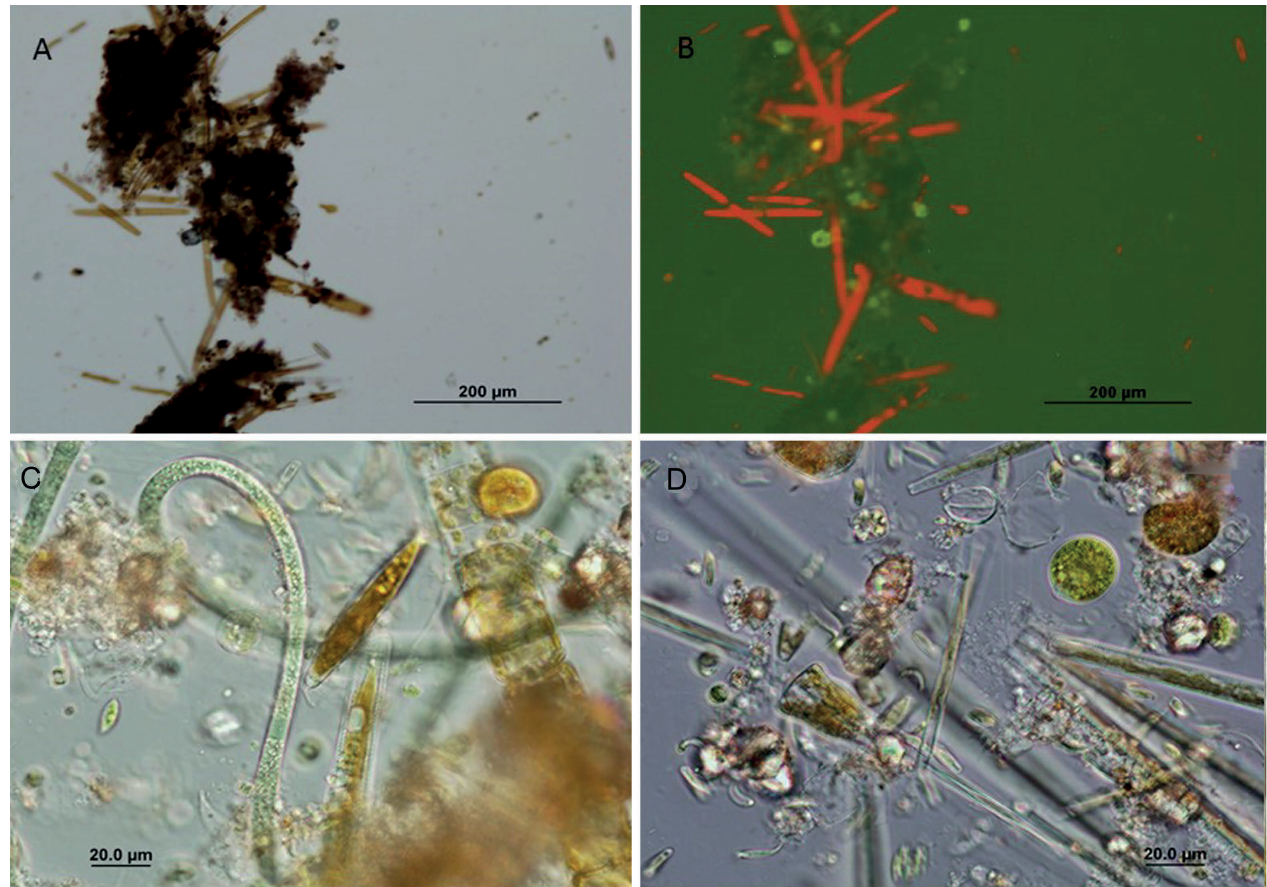
Figure 1 – Illustrations of the complex, jumbled and non-random world of freshwater biofilms as encountered with the light microscope: A, representatives of several autotrophic groups live in, on and around organic and inorganic debris, along with fungi, bacteria, heterotrophic protists and higher organisms: epilithic biofilm from Winford Brook (latitude: 51.36697, longitude: -2.621881). Organic material obscures many live cells; B, using chlorophyll autofluorescence imaging, location of pigmented cells is revealed; C, closer inspection of dispersed biofilm material reveals single-celled and filamentous diatoms intertwined with other phototrophs such as filaments of cyanobacteria; D, colonies of Scenedesmus and live and empty cells of dinoflagellates are located amongst the diatoms and mineral particles. Light microscopy was undertaken using a Leica DM LB2 microscope (Wetzlar, Germany) with an Olympus DP70 camera (Hamburg,